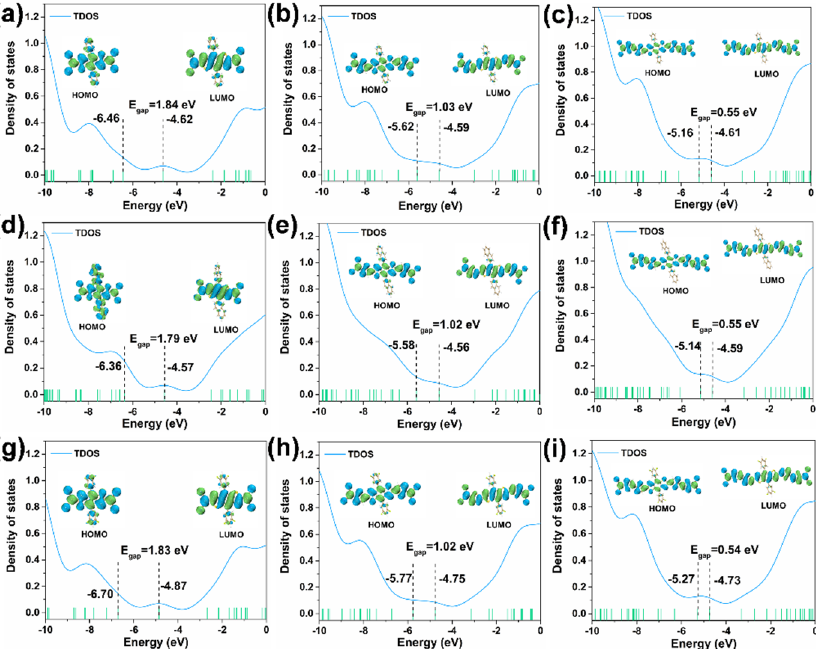
Figure 2. DOS curves of the nine compounds. ( a − i ) are compounds (1 − 9).